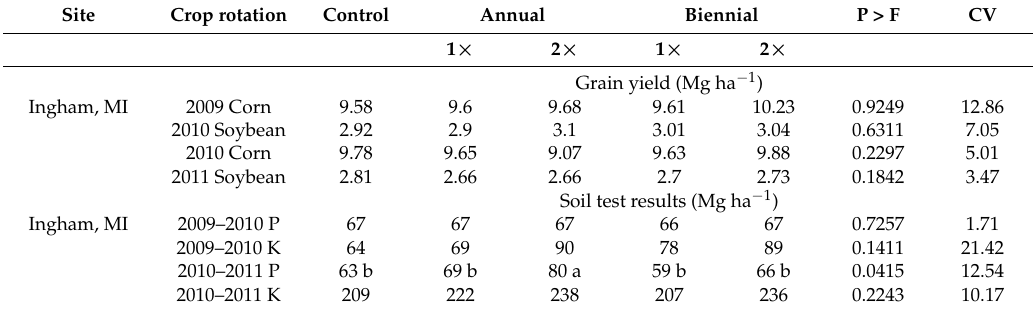
Table 8. Corn and soybean grain yield and soil test results affected by fertilizer treatments at sites with above optimal P and above optimal